Question: Condense the content of this figure into a single sentence.
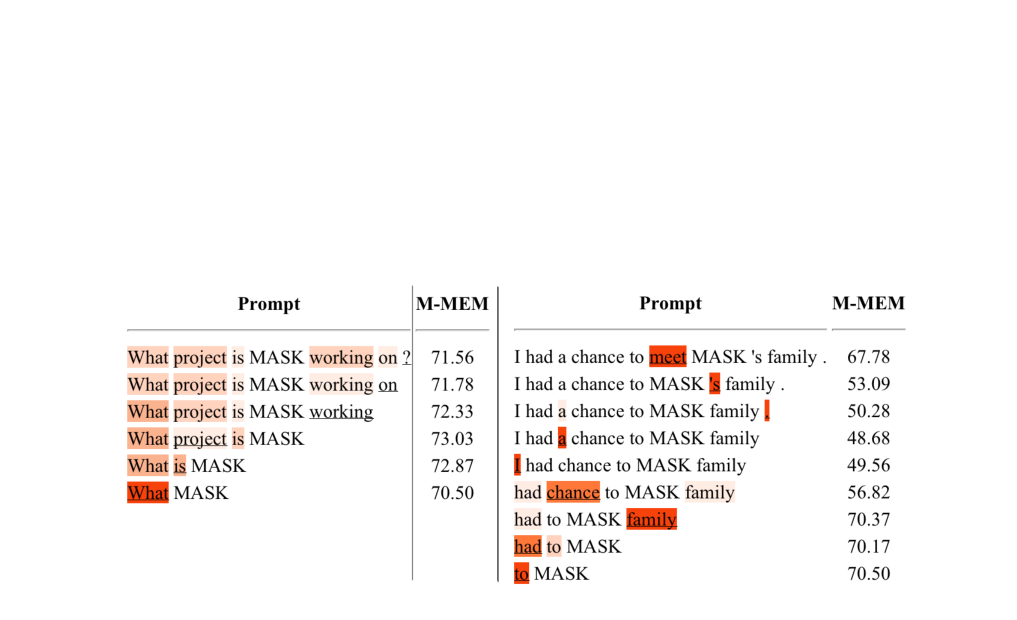
Answer: Analysis of the token importance in prompts and the M-MEM scores for the M-MEM score of the BERT-L model. The best-performing (on the left) and the worst- performing (on the right) prompts were selected on the dev set. The heatmaps are generated with leave-one-token-out: at each step, the least important token is removed from the best-performing prompt (left), and the most important token is removed from the worst- performing prompt (right). The removed tokens are underlined.